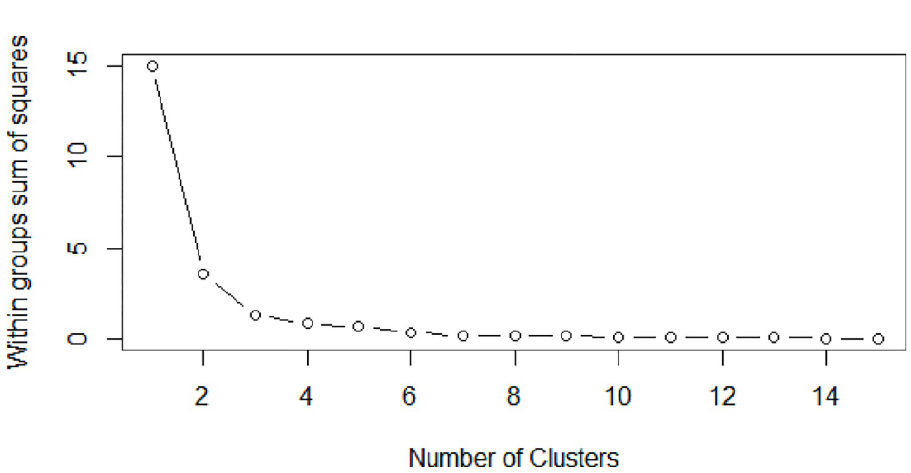
Fig 2. Clustering results of 16 heavy polluting industries under k-means.